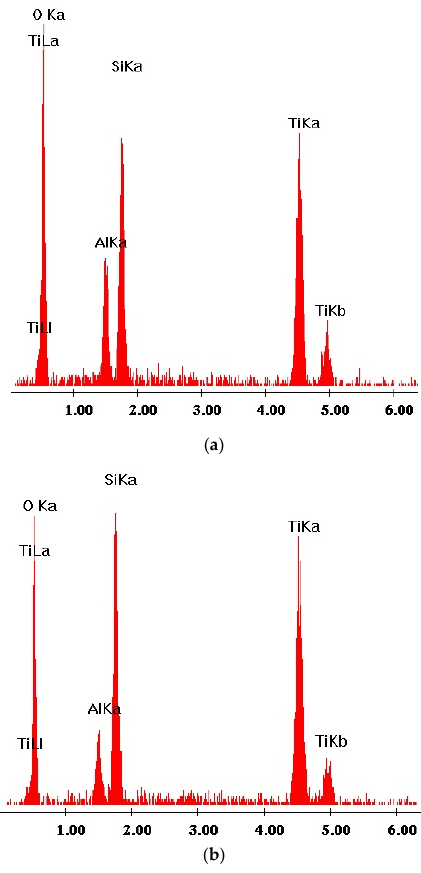
Figure 10. EDX microanalysis at points 1 ( a ) and 2 ( b ) on the surface of the thin film deposited from Aerosil TM solution on titanium and shown in Figure